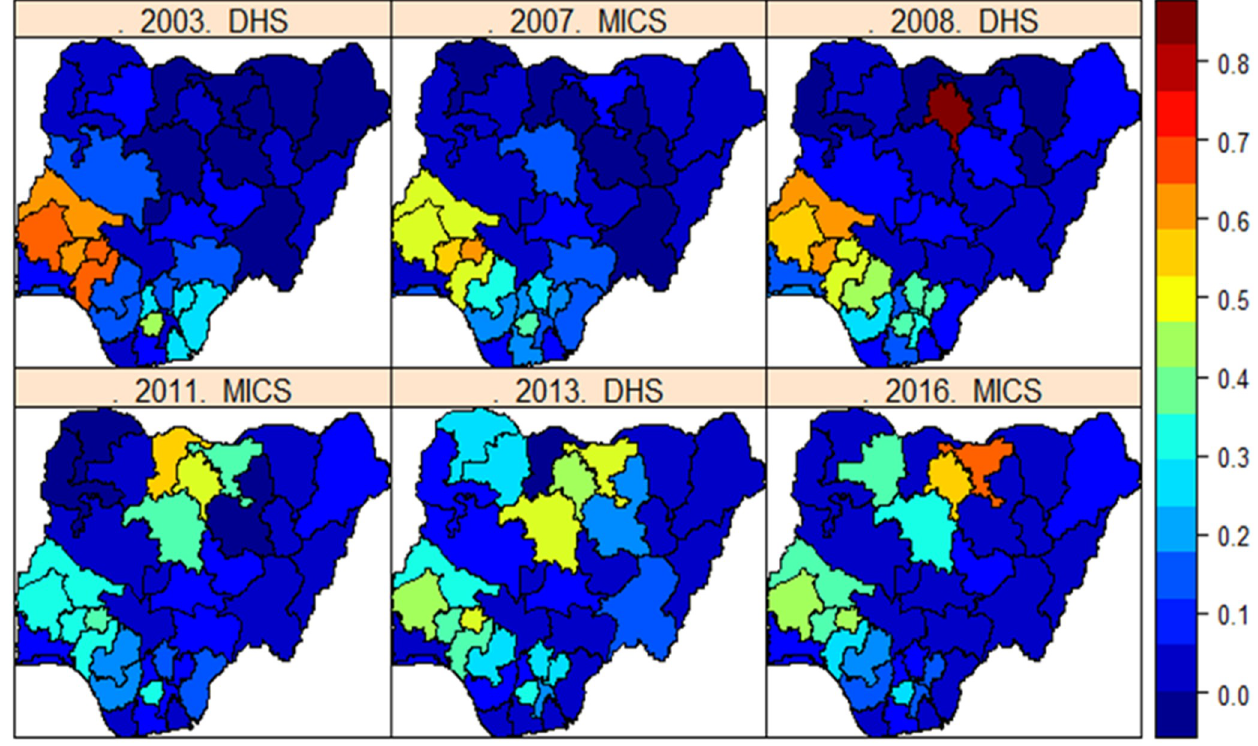
Fig 3. Crude estimates of the spatial distribution of FGM/C prevalence among 0-14-year old girls across the Nigerian 36 states and the FCT. Dark blue to dark red correspond to lowest to highest prevalent states. Shapefile republished from DIVA-GIS database (https://www.diva-gis.org/) under a CC BY license, with permission from Global Administrative Areas (GADM), original copyright 2018.